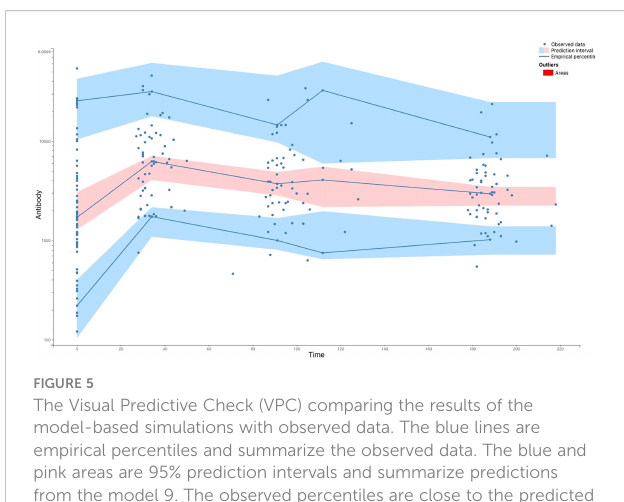
FIGURE 5 The Visual Predictive Check (VPC) comparing the results of the model-based simulations with observed data. The blue lines are empirical percentiles and summarize the observed data. The blue and pink areas are 95% prediction intervals and summarize predictions from the model 9. The observed percentiles are close to the predicted percentiles and remain within the corresponding prediction